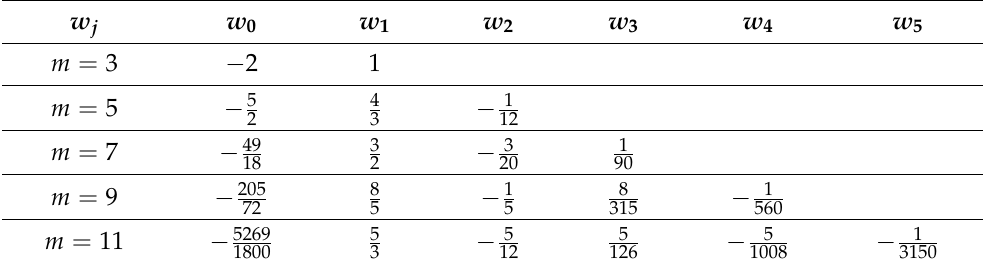
Table 1. The weights w j in (2) for different values of m . Here we present only w j for j ≥ 0 as the weights remain symmetric for every j , e.g., w j = w − j